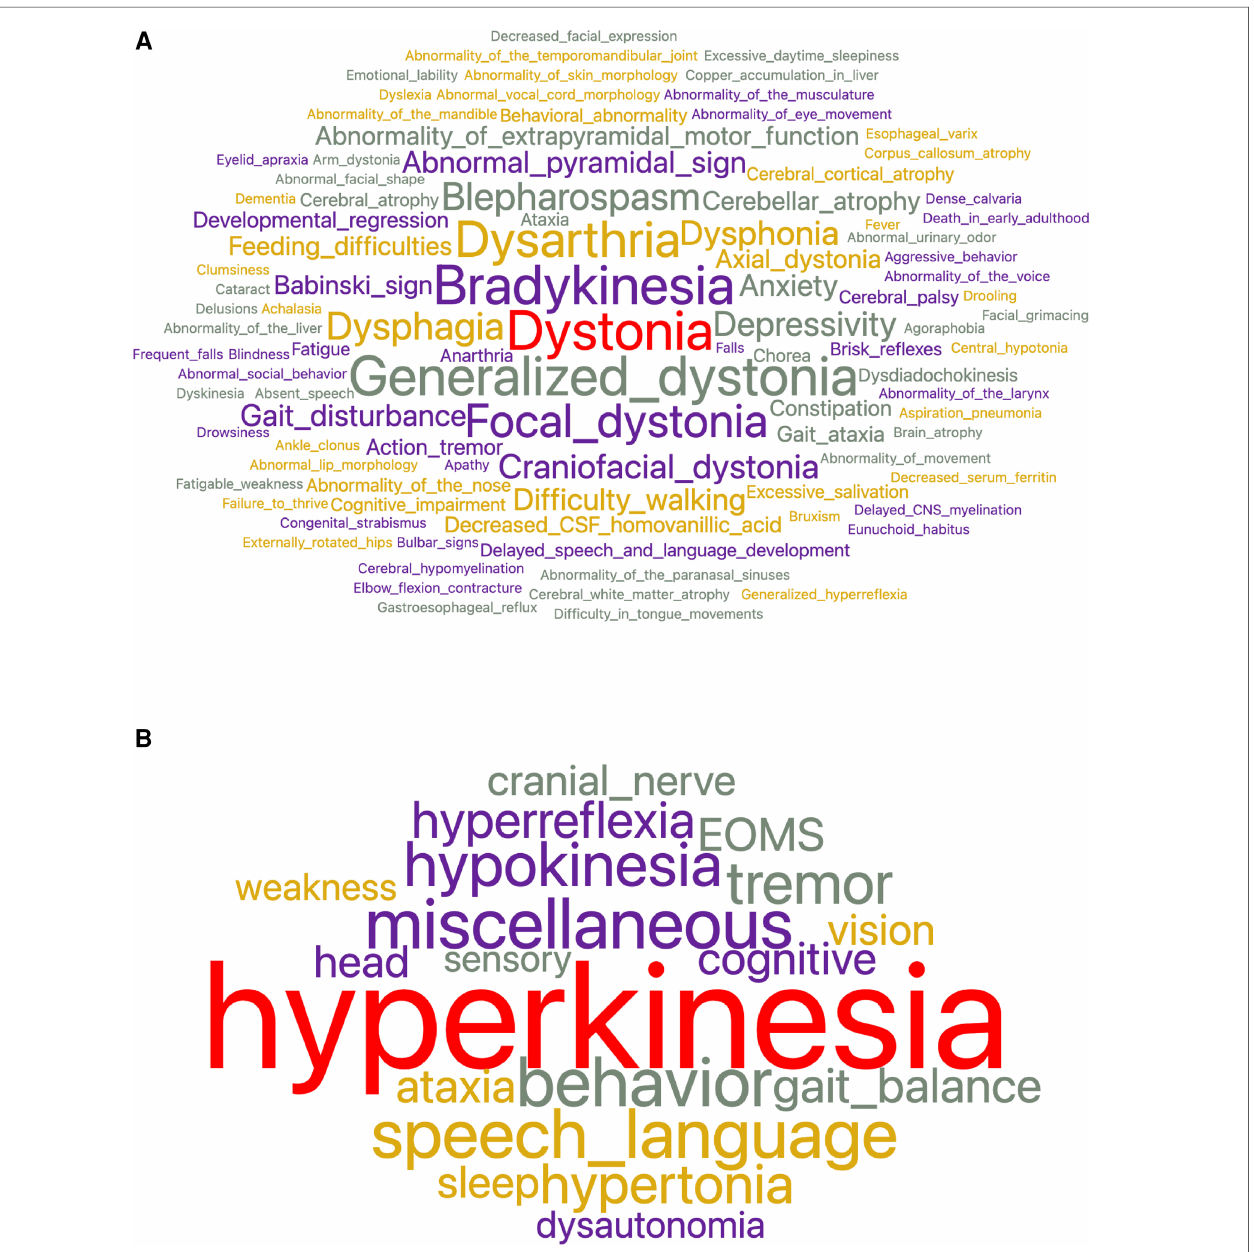
FIGURE 1 ( A ) To characterize the 32 dystonic diseases, 528 total concepts and 252 unique concepts were used. The most frequent concepts used were dystonia, bradykinesia, generalized dystonia, dysarthria, and focal dystonia. ( B ) After feature reduction by subsumption, the number of superclasses needed to characterize dystonia diseases was reduced to nineteen. The largest superclass is hyperkinesia which encompasses dystonia, generalized dystonia, focal dystonia, blepharospasm, craniofacial dystonia, and